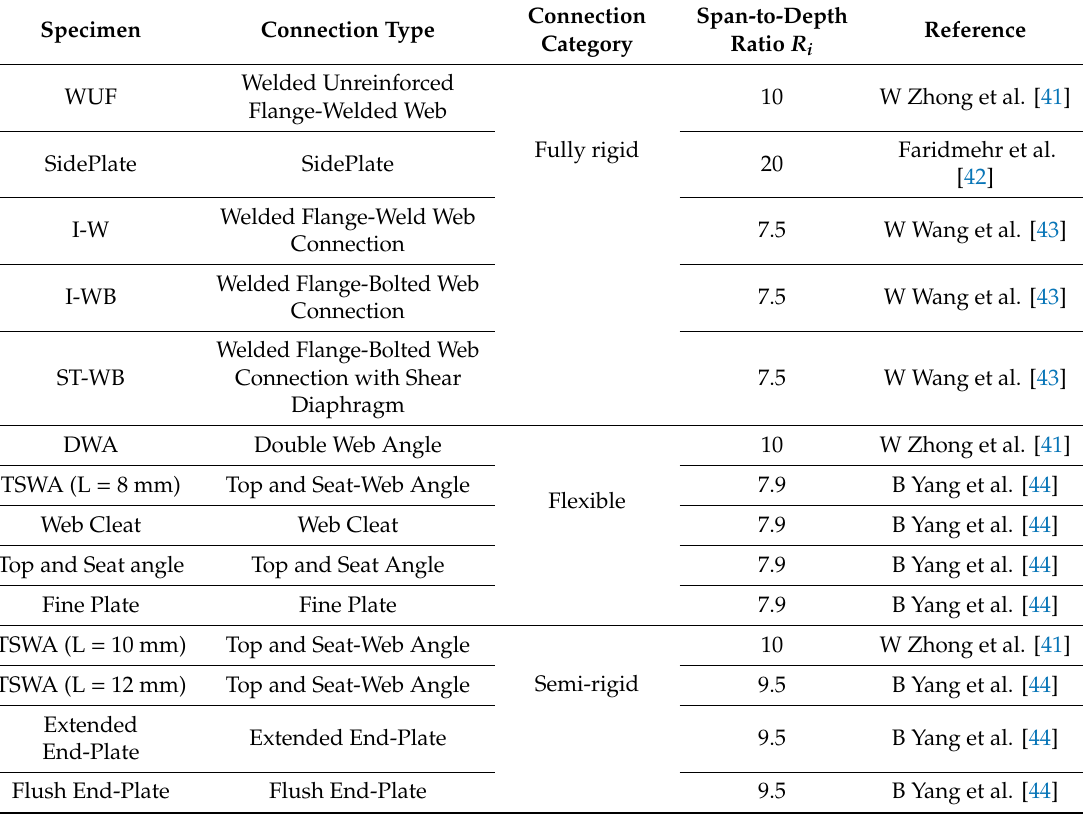
Table 2. Summary of Tested Specimens.